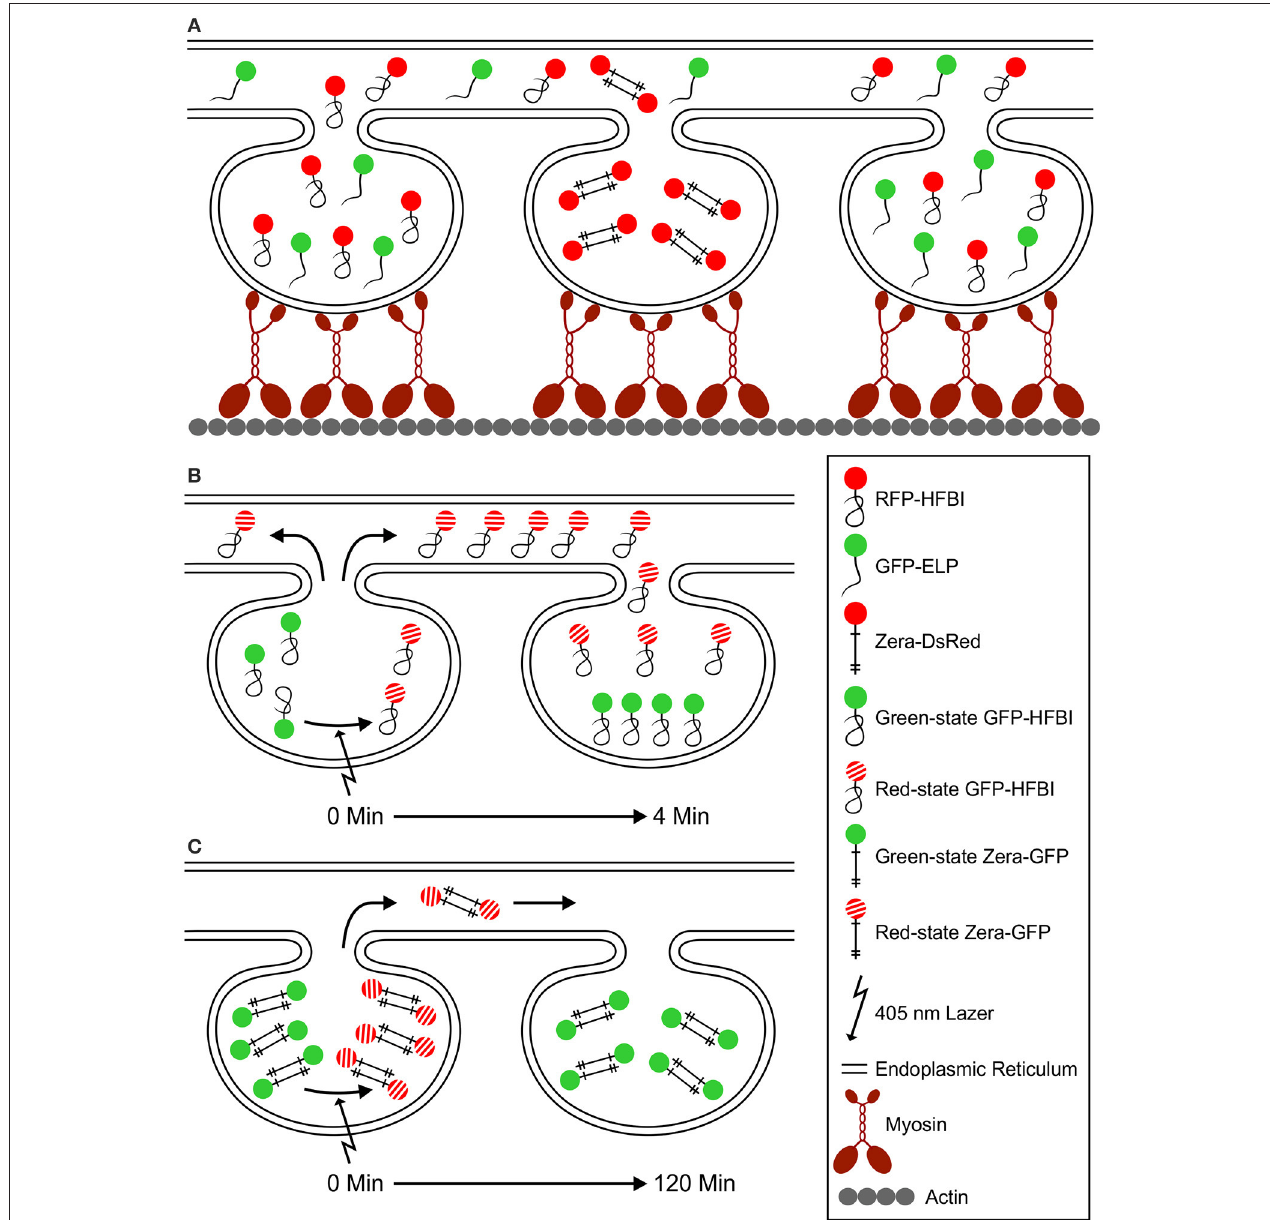
FIGURE 9 | A model for PB movement and active exchange of PB content via the ER. (A) Zera, ELP and HFBI PBs are surrounded with an ER membrane and are mobile in vivo . Myosin motor proteins attach to the ER with their globular tail domain and to actin filaments with their motor domain (Peremyslov et al., 2012). PB mobility depends on ER movement at contact points with the actomyosin cytoskeleton. Upon co-expression of different protein fusions, ELP and HFBI fused proteins co-localize to the same PBs, but not with Zera-fused proteins. This is due to the high affinity of Zera molecules to one another that is the result of intermolecular disulfide bridges between cysteine residues (shown with crosses). (B) Upon photoconversion of GFP from green- to red-state, GFP-HFBI molecules travel (in < 4 min) from one PB to another through the ER. ELP fusion proteins act similar to HFBI fusions upon photoconversion (not shown in this model). (C) Zera-GFP molecules do not fold after synthesis, preserve their sticklike structure, and form intermolecular disulfide bonds, and therefore are less mobile (soluble) compared to HFBI or ELP protein fusions. By photoconverting the content of Zera-GFP PBs, they immediately change from green to red state, but the movement from one PB to another happens in a very slow fashion when compared to HFBI and ELP protein fusions. Very little protein movement is observed 120 min after photoconversion.